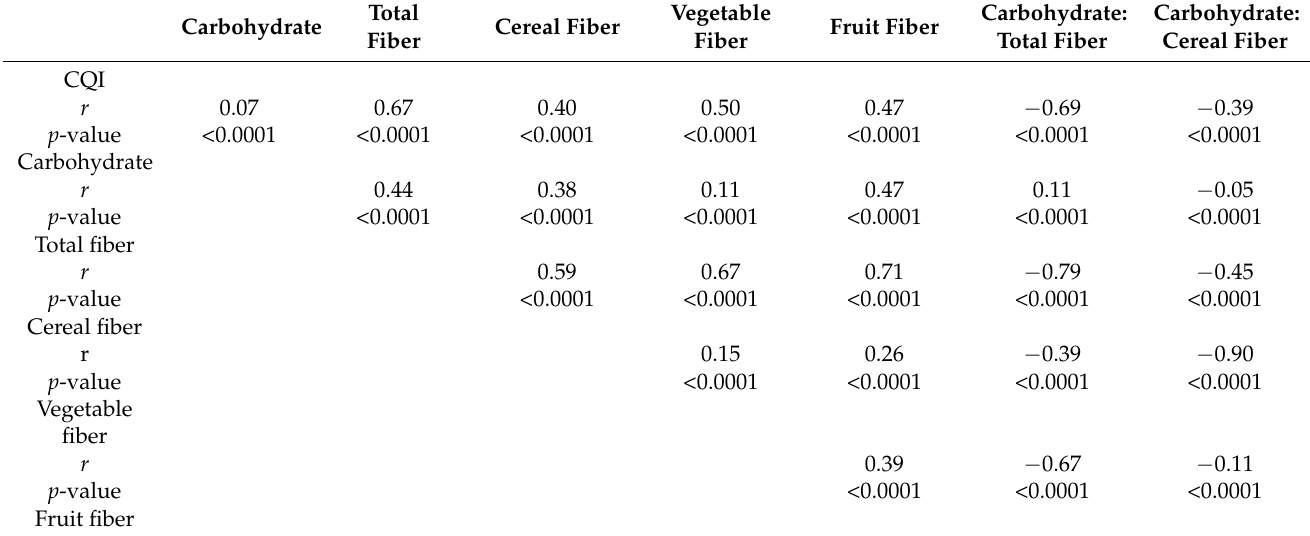
Table 4. Spearman correlation coefficients between energy-adjusted carbohydrate quality